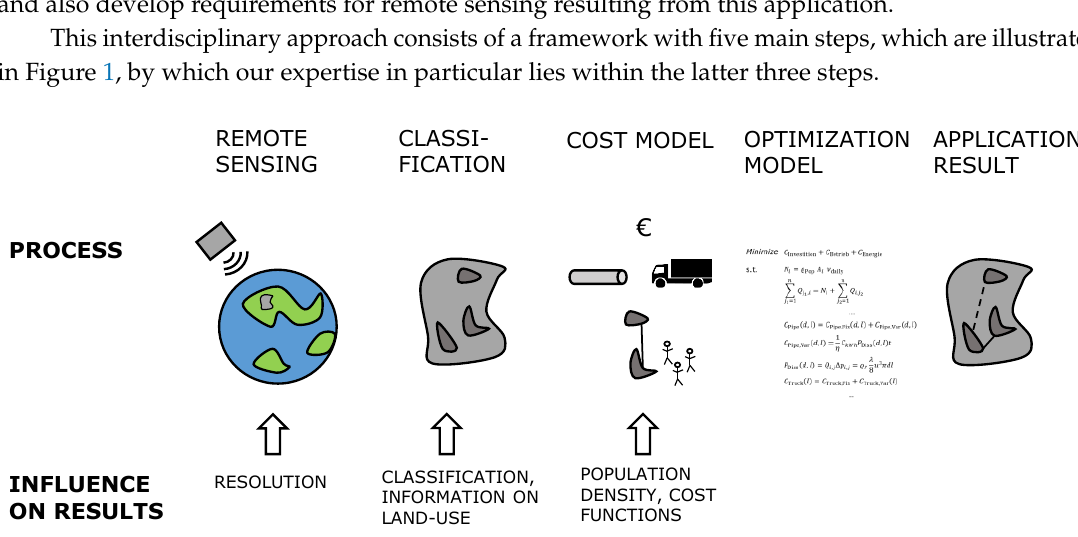
Figure 1. Framework of the holistic concept to design optimal water supply